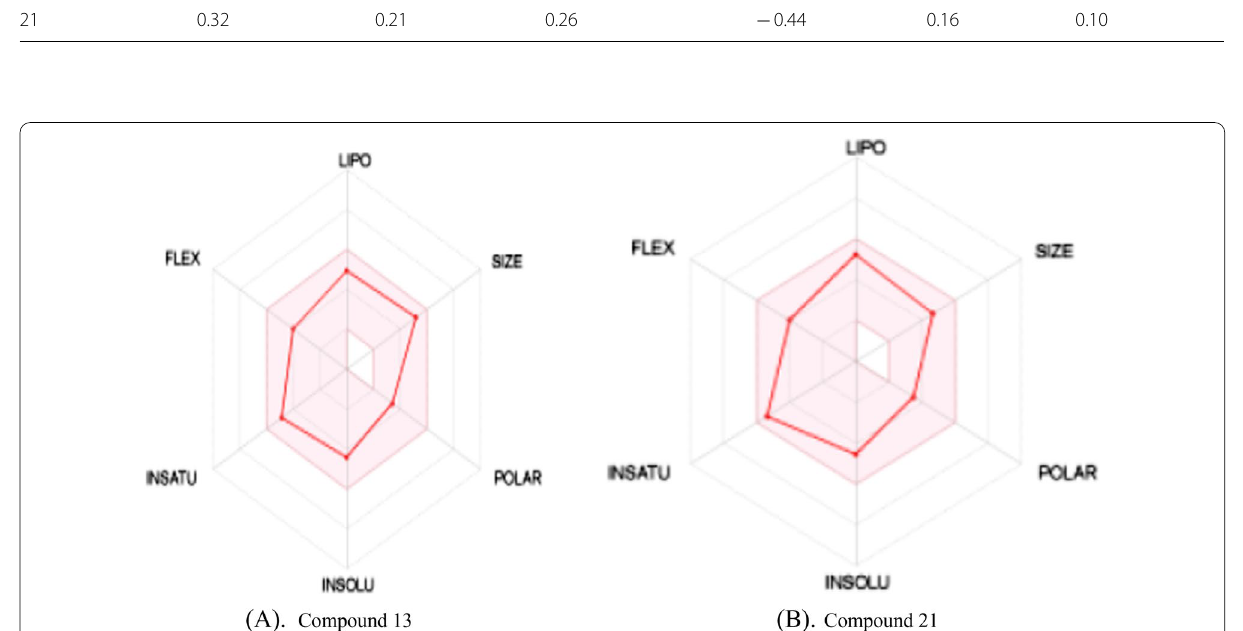
Fig. 8 Radar plots of six drug-likeness parameters used to calculate the oral bioavailability of the studied